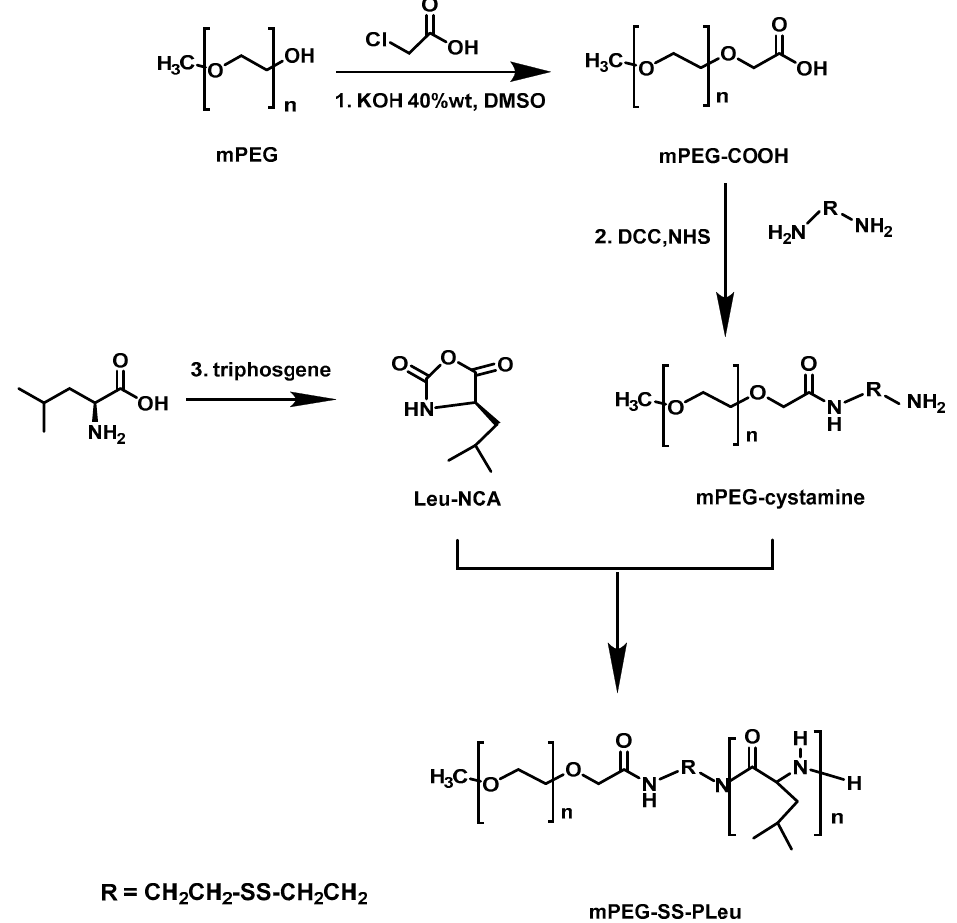
Figure 10. Synthesis of the mPEG-SS-Pleu copolymer via disulfide bond conjugation.